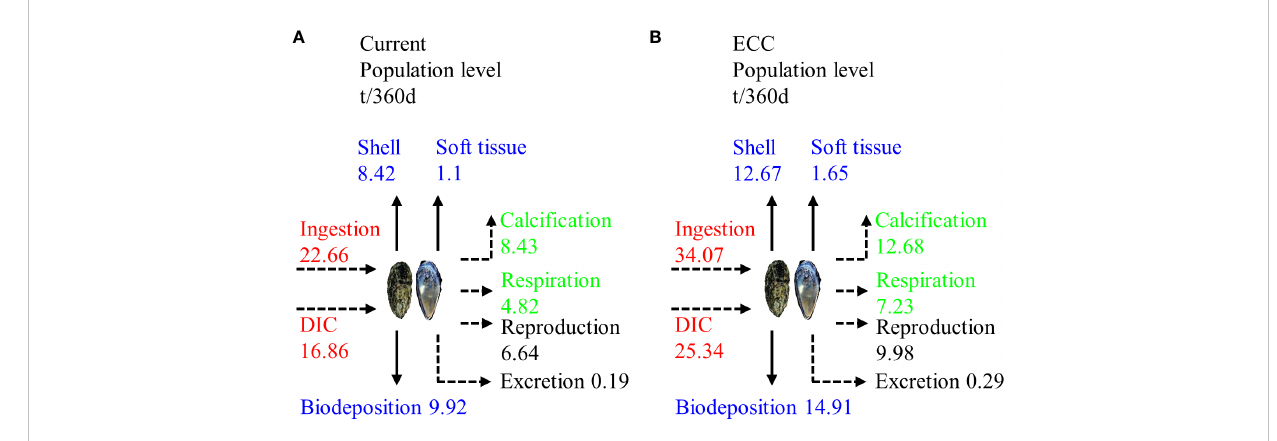
FIGURE 6 Carbon budget of bivalve shell fi sh populations in the study marine ranching under two scenarios for (A) current and (B) ECC. ECC, ecological carrying capacity; DIC, dissolved inorganic